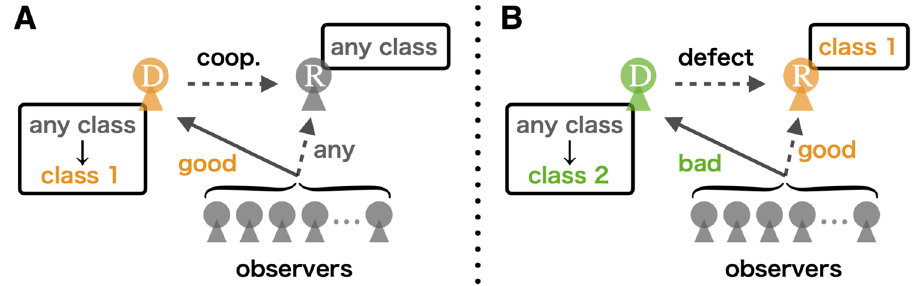
Figure 5. An interpretation of the equilibrium state for SS. ( A ) When a donor cooperates with a recipient, the donor receives good reputations from a lot of observers, independent of classes of the donor and the recipient. Such a donor moves to class-1. Because this process frequently occurs, SS generates a majority of individuals with high goodness. ( B ) When a donor defects with a recipient in class-1, the donor receives bad reputations from a lot of observers and such a donor moves to class-2. This process does not frequently occur, but SS definitely generates a minority of individuals with low